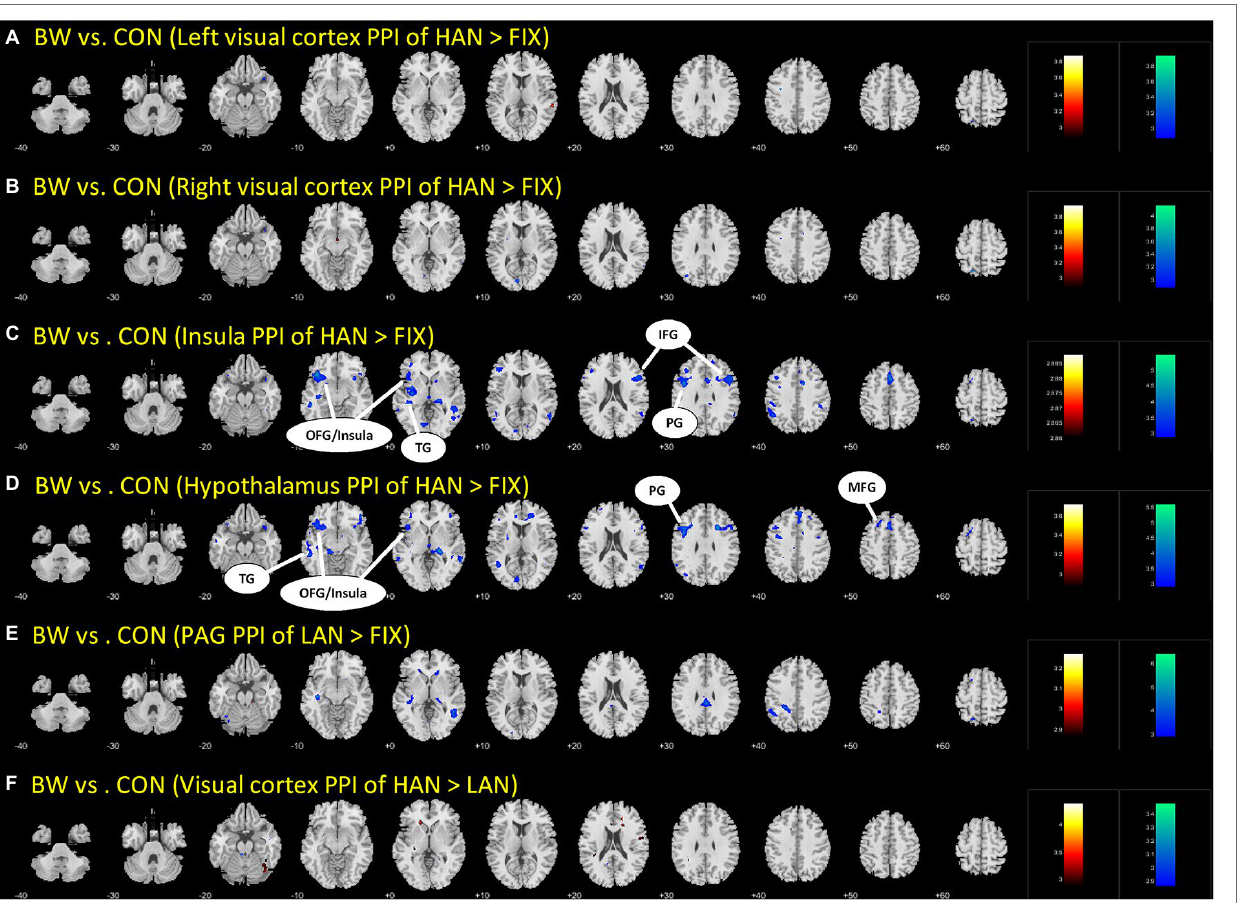
FIGURE 3 | The different parts (A-F) are simply the different brain regions and conditions tested in the PPI analysis. Differences in PPI between BWS and CON during HAN image presentation. OFG, Orbitofrontal gyrus; TG, temporal gyrus; IFG, inferior frontal gyrus; PG, Precentral gyrus; and MFG, Middle frontal